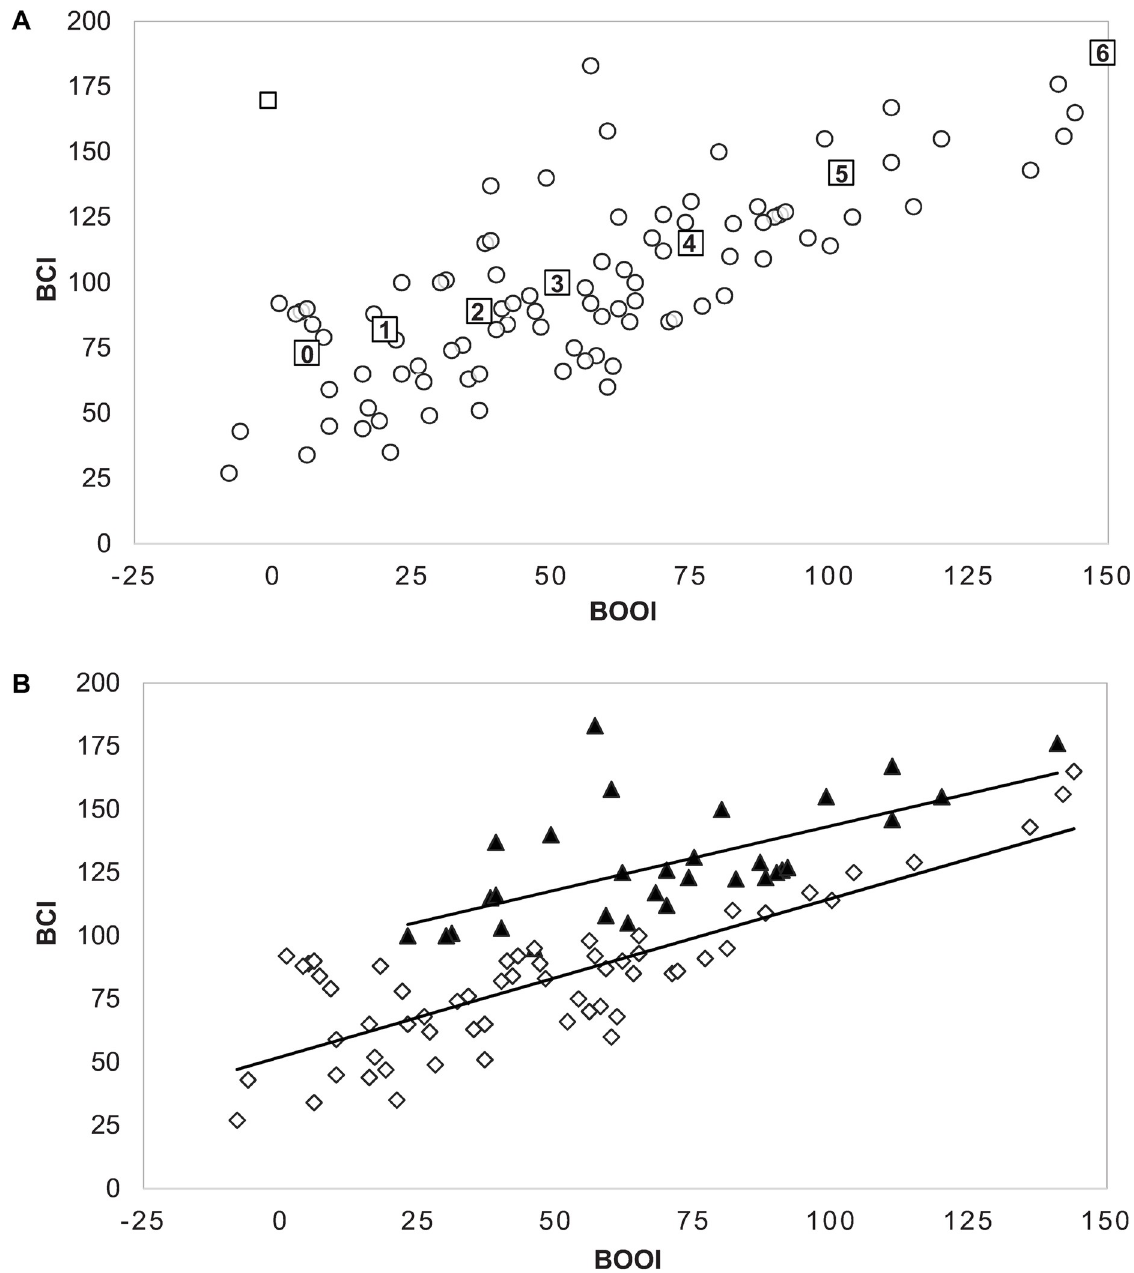
Fig 4. BOOI and BCI are positively correlated. (A) Plot of BCI vs BOOI for all 94 patients illustrating a positive correlation (r = 0.75). Data from Oelke et al. (2014) showing mean BCI and BOOI for Schaffer grades 1–6 in 786 men with LUTS suggestive of BPH is superimposed. (B) Plots of BCI vs BOOI for Cluster 1 (filled triangles) and Cluster 2 (open diamonds). Both clusters exhibit a positive correlation (r = 0.63, p < 0.001 and r = 0.82, p < 0.001,